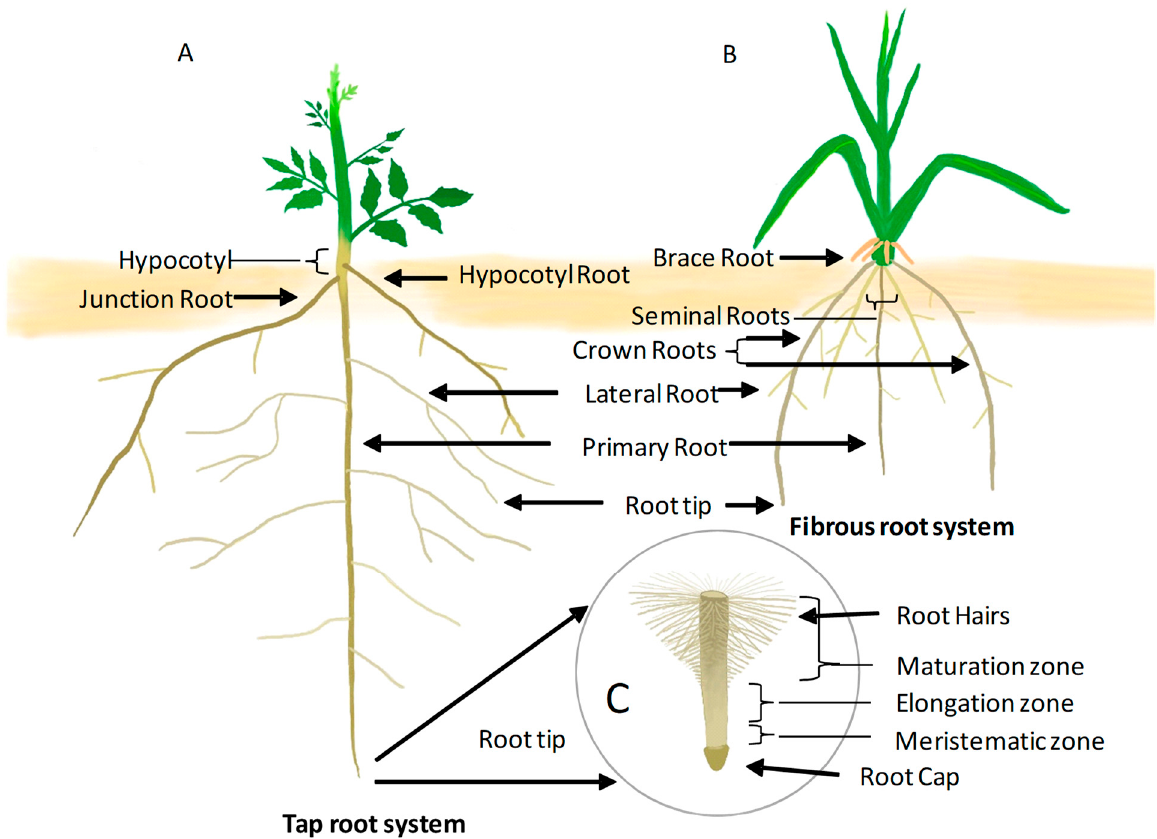
Figure 1. ( A ) Tap root system: RSA of a dicot (tomato) showing embryonic primary root, lateral roots, adventitious roots of shoot origin (hypocotyl root), and root-shoot junction (junction root). ( B ) Fibrous root system: RSA of a monocot (maize) showing embryonic origin primary root and seminal roots, adventitious roots of shoot origin (brace roots) and root-shoot junction (crown root), laterals, and root tip. ( C ) Root tip of primary root showing root cap, meristematic zone, elongation zone, and maturation zone having root hairs.